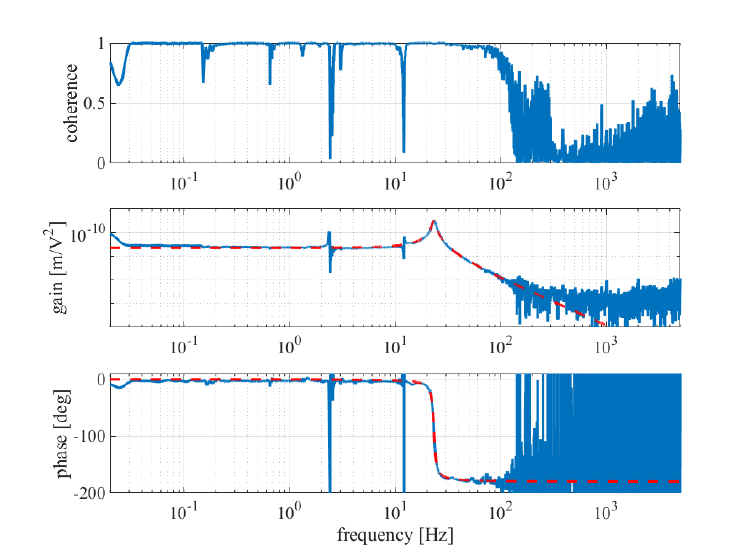
Figure 11. Coherence ( top ), gain ( middle ), and phase ( bottom ) of the experimental frequency response (blue solid line) of the mechanical compliance. The identified model G (red dashed line) is also shown. The graph shows the case of weight M = 52.8 g.